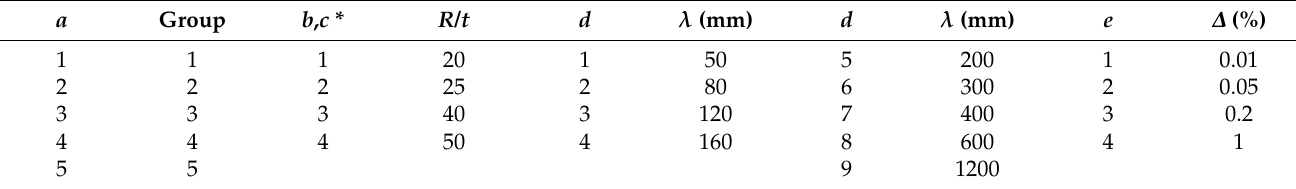
Table 7. Explanation of case names.